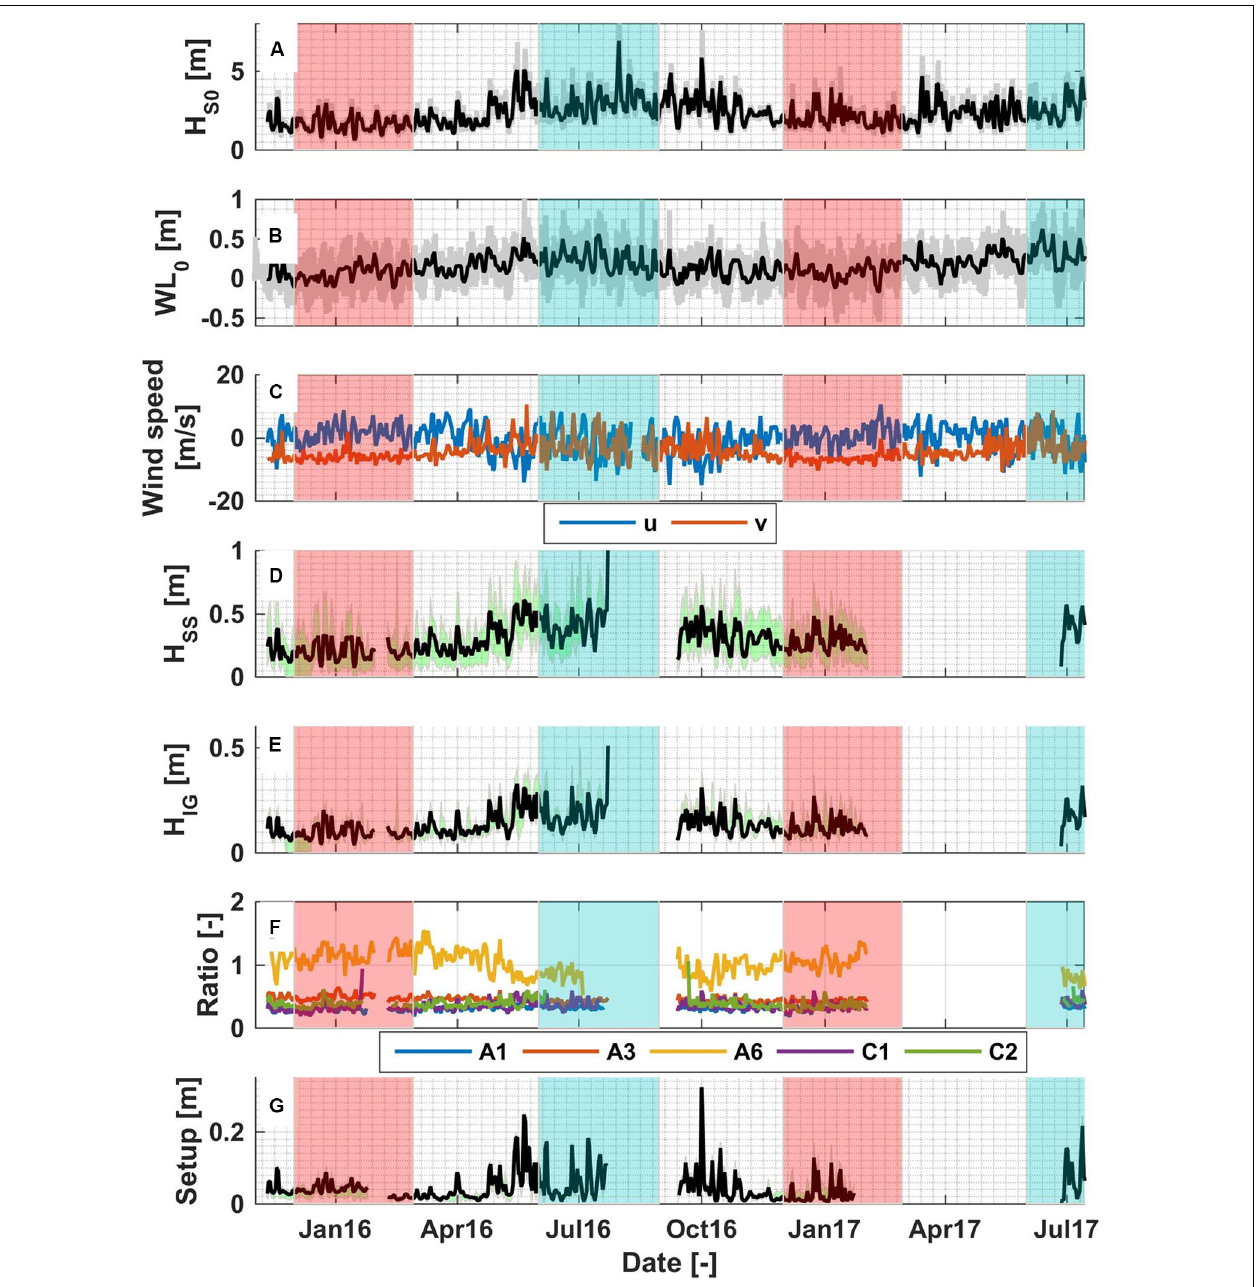
FIGURE 4 | Daily average (solid black line) and hourly (solid gray line) (A) offshore significant wave height. (B) Non-tidal (solid black line, filtered using PL66TN with a half-power cutoff period of 33 h) and hourly water level (solid gray line) variations. (C) East ( u , blue line) and north ( v , red line) components of daily wind speed. (D) Daily sea-swell (SS) and (E) infragravity (IG) wave heights at site A3, chosen to represent the conditions inside the lagoon. (F) Ratio between IG and SS at selected observation points. (G) Daily wave setup at A3. Gray lines and green areas at figure (D,E,G) denote the range of value among the sensors inside the lagoon. Transparent red and blue regions denote periods of the austral summer and winter,